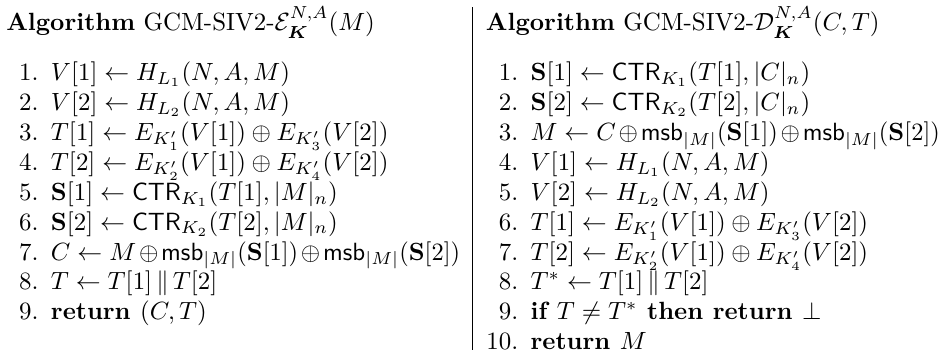
Algorithm GCM-SIV2- E N,A